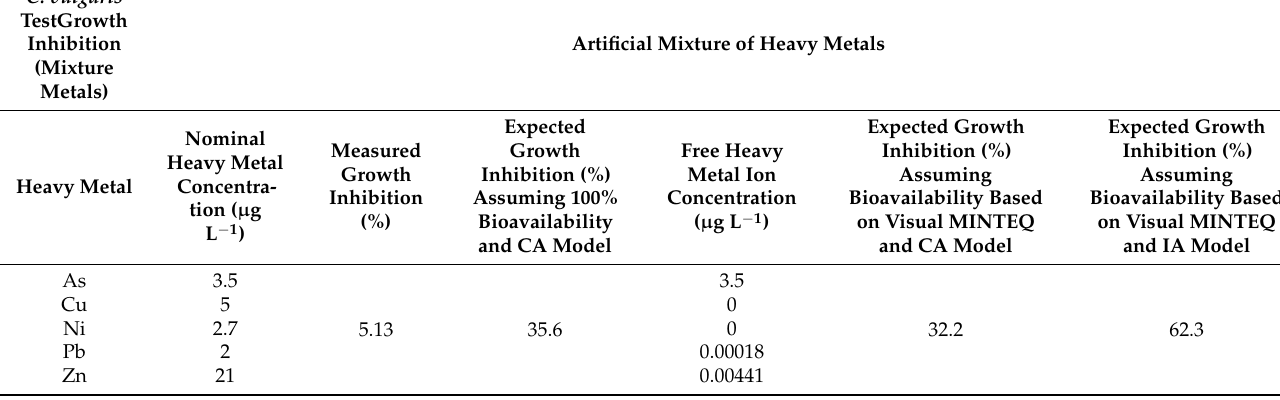
Table 5. Expected growth inhibitions for 48 h exposure to the artificial mixture calculated with concentration-response curves using concentration addition (CA) and independent action (IA) models.